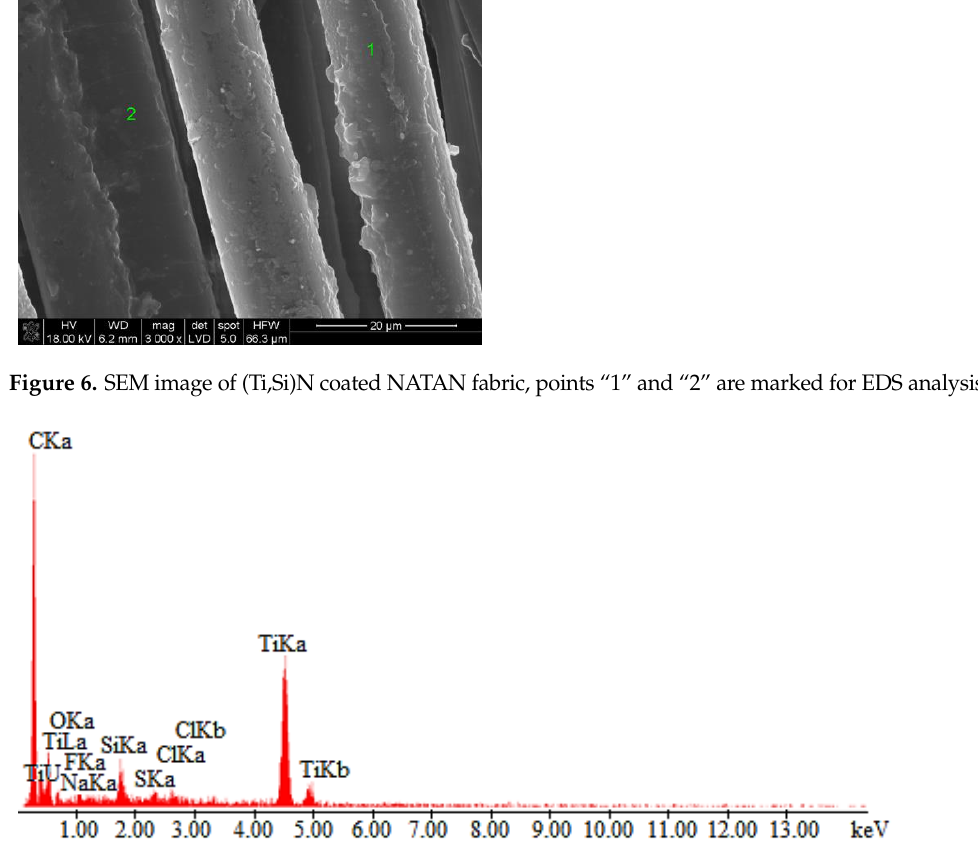
Figure 7. EDS spectrum of element distribution for (Ti,Si)N coated NATAN fabric at point “1” (Figure 6).